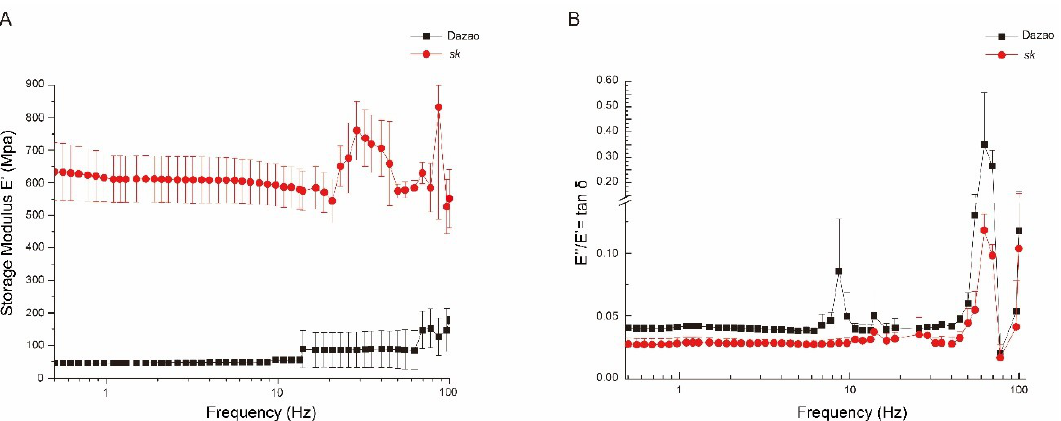
Figure 2. Mechanical properties of day 3 of the fifth instar larval cuticles between Dazao and sk mutant. ( A ) Storage modulus (E′) of L5D3 larval cuticles of wild-type Dazao and sk mutant under frequency scanning ( n = 3). ( B ) tanδ (E′′/E′) of L5D3 larval cuticles of wild-type Dazao and sk mutant under frequency scanning ( n = 3).